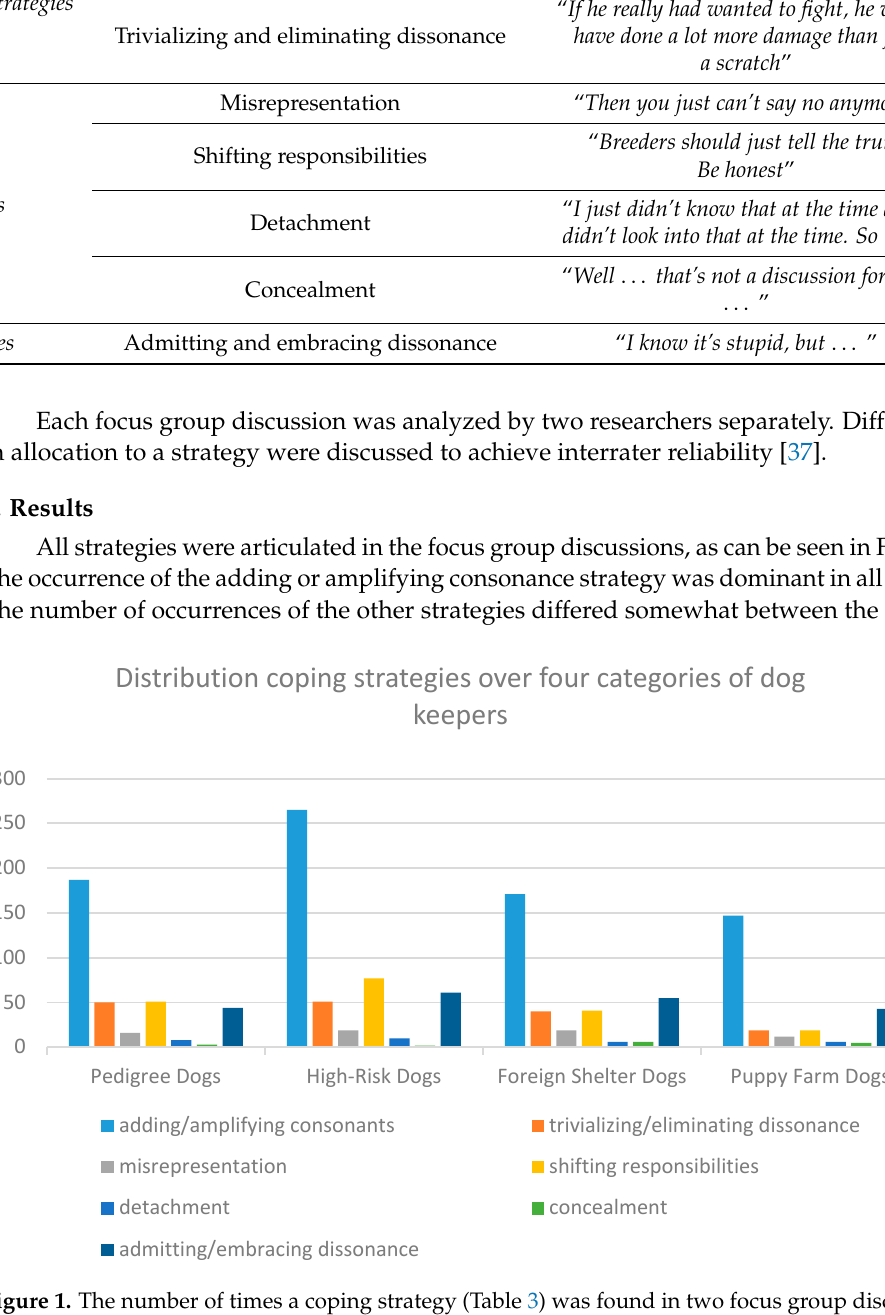
Table 3. Framework for categorizing coping strategies based on Festinger [35], Serpell [36], and Nijland [31].